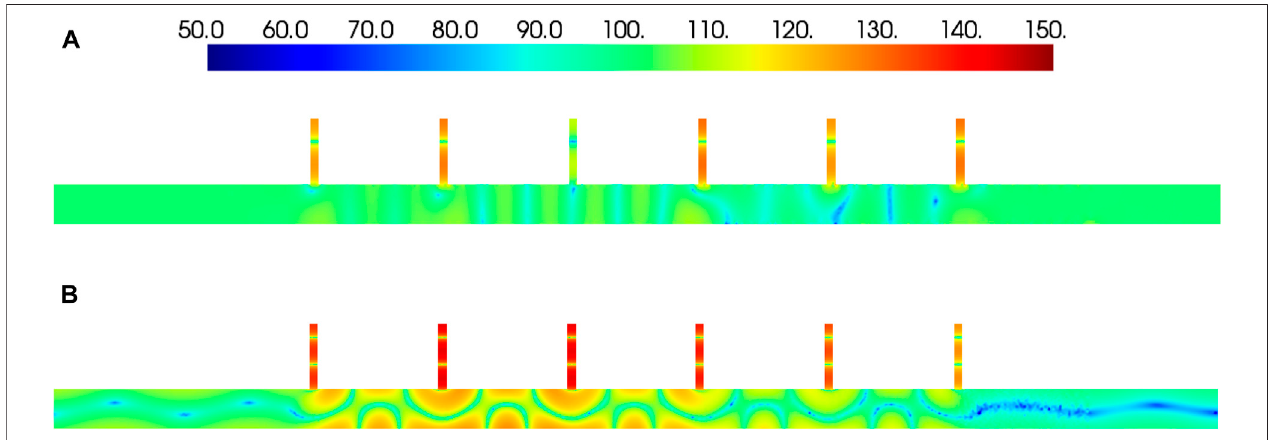
FIGURE 11 | Sound pressure contour at different frequencies/dB: (A) The SPL contours of 490Hz; (B) the SPL contours of 820 Hz.